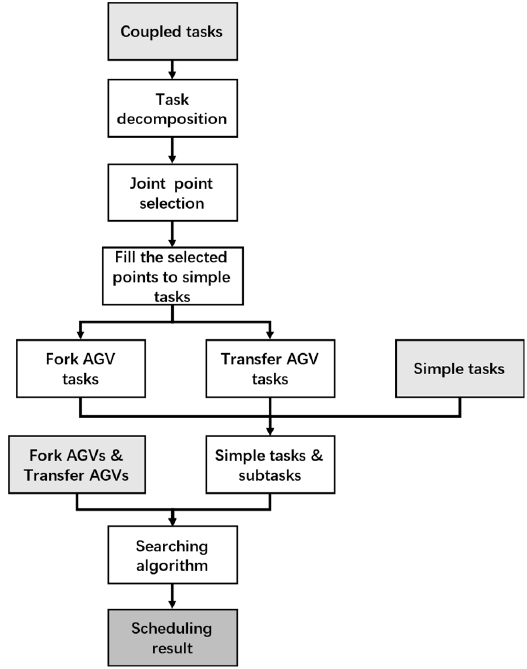
Fig. 3. The flow chart of decoupled scheduling